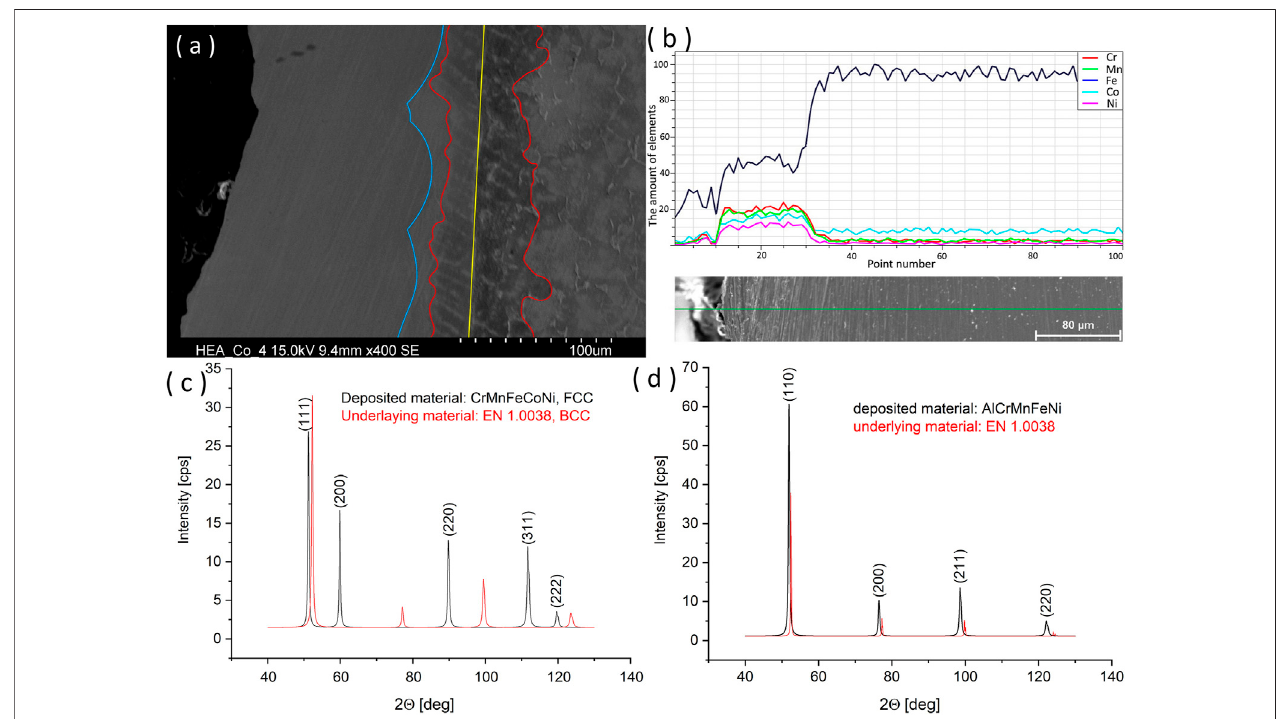
FIGURE 6 | SEM image of the 3D-printed Cantor alloy on a carbon steel plate (sample #4) (A) , an EDX line analysis of sample #3 after corrosion test (B) and XRD patterns of the deposited CrMnFeCoNi (C) and AlCrMnFeNi (D) coatings.